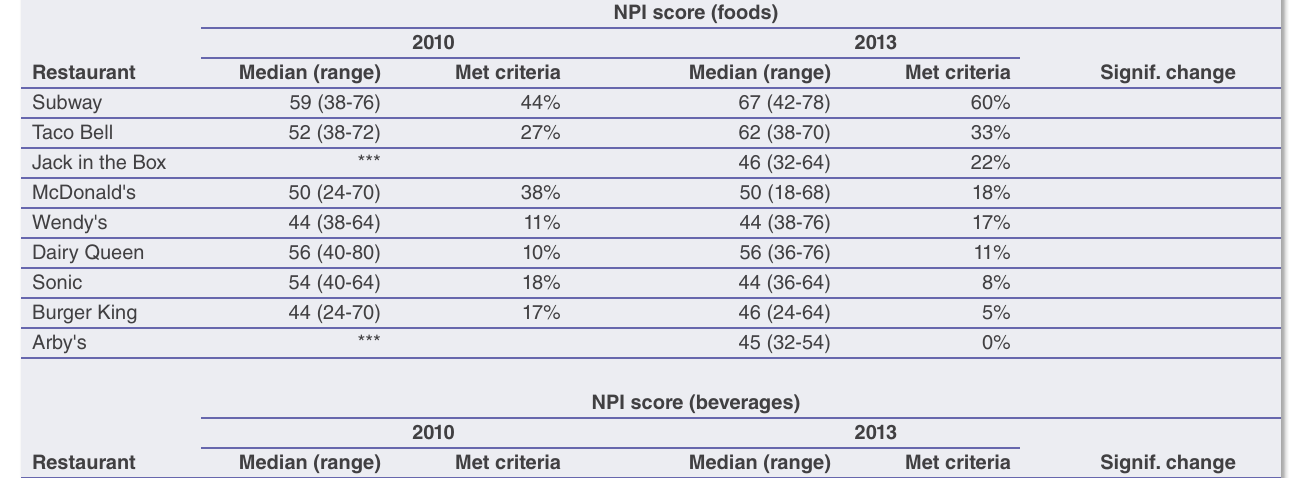
Table 12. Nutrient content of menu items available on dollar/value menus NPI score (foods) 2010 2013 Restaurant Median (range) Met criteria Median (range) Met criteria Signif. change